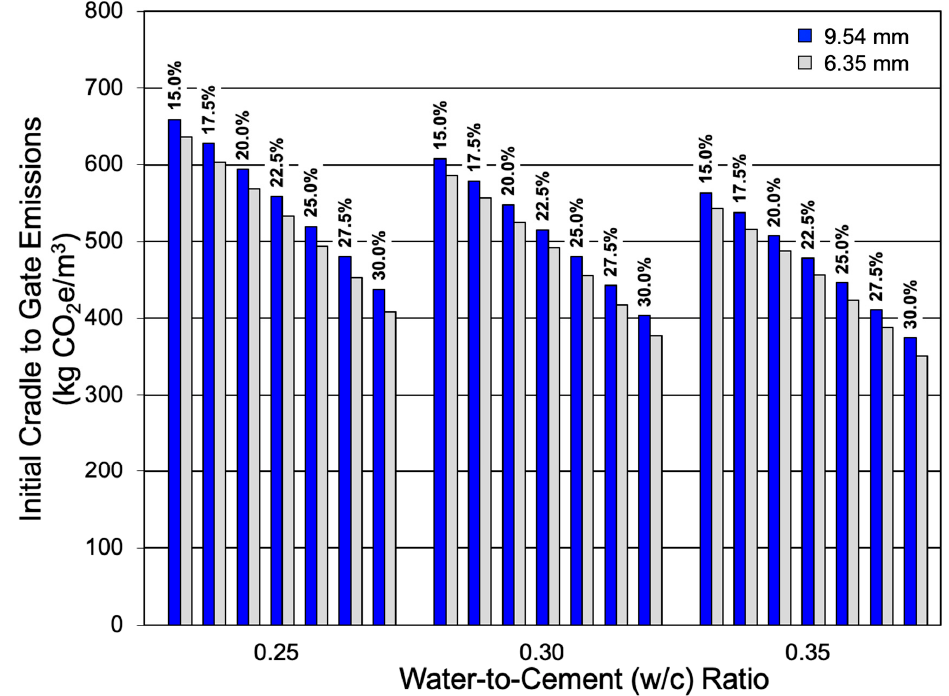
Figure 2. Initial cradle-to-gate CO 2 e emissions of pervious concrete mixtures designed according to the NRMCA design methodology [35,36]. Design porosity of each mixture is indicated above its respective column. Aggregate size is differentiated by color.